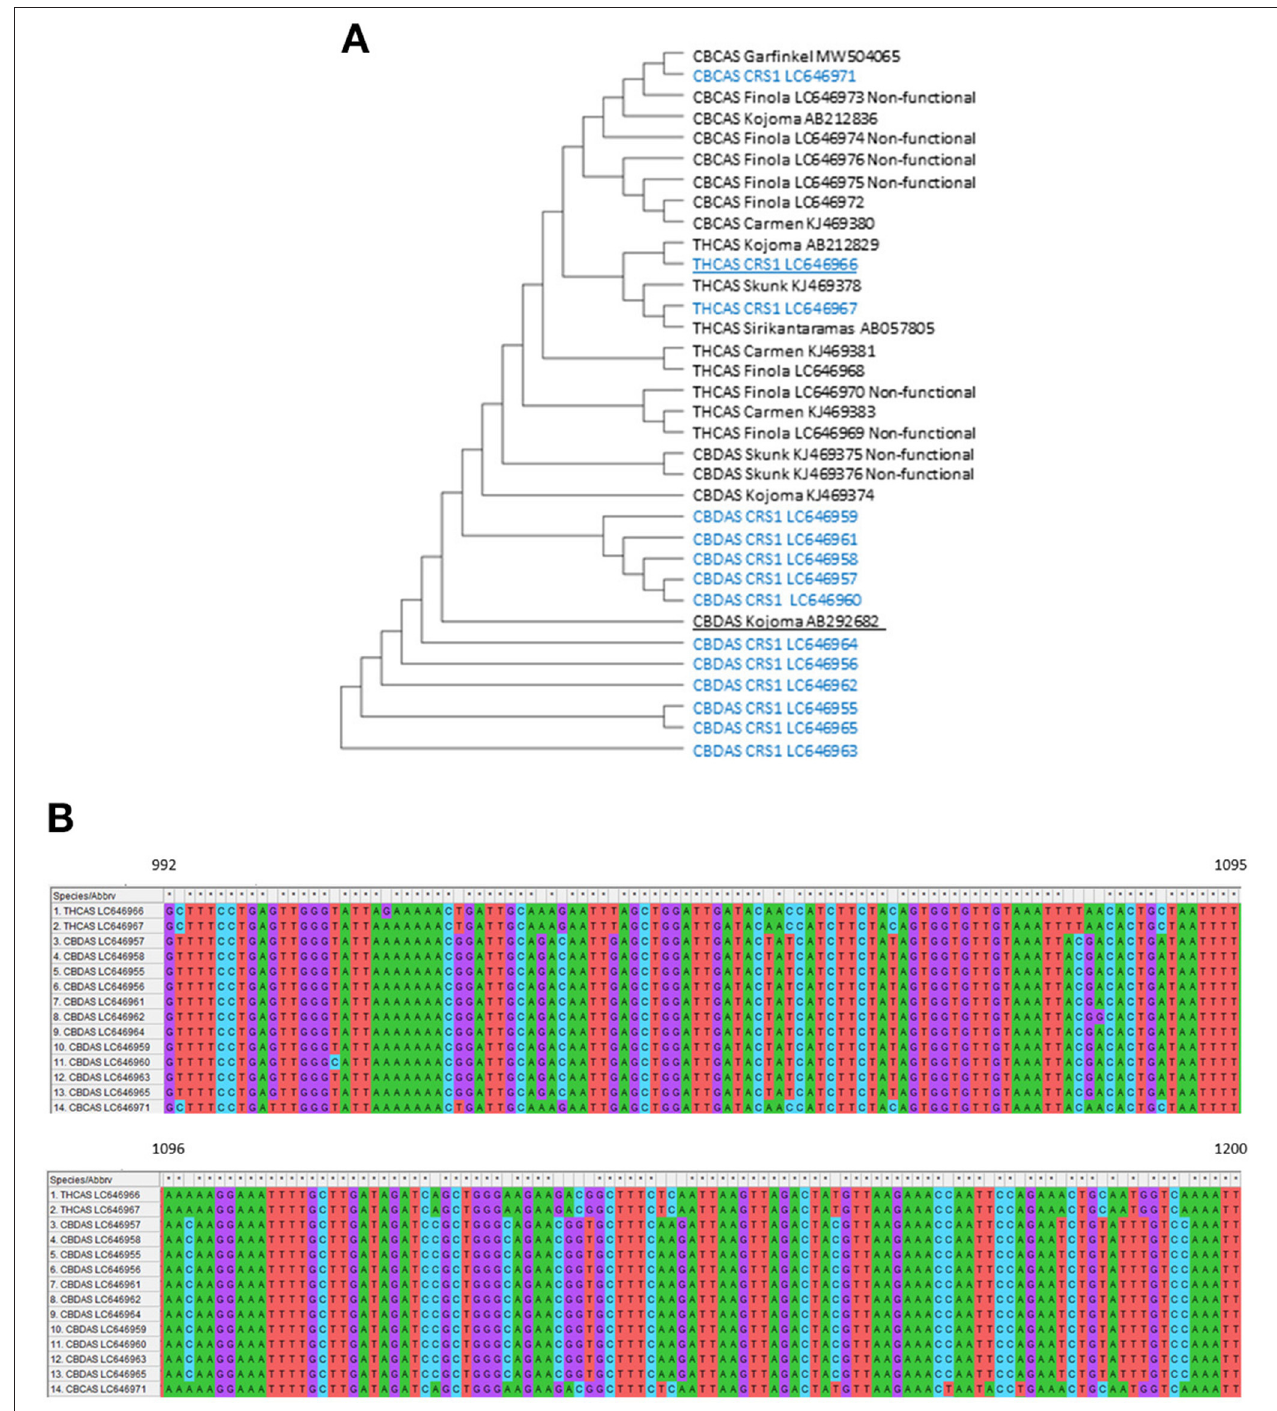
FIGURE 3 | (A) Construct/test maximum parsimony tree of the CBDAS, THCAS, and CBCAS gene sequences inferred from a 1452 bp alignment of 14 unique sequences obtained from RT-PCR in “CRS1” (No. of Bootstrap Replications were 2000). The blue letter represents expressed sequences in “CRS1.” Underlined copies were used to build binary vectors. (B) Sequence alignment of CBDAS, THCAS, and CBCAS from 992nt-1200nt. All sequences were obtained from RT-PCR in “CRS1”.